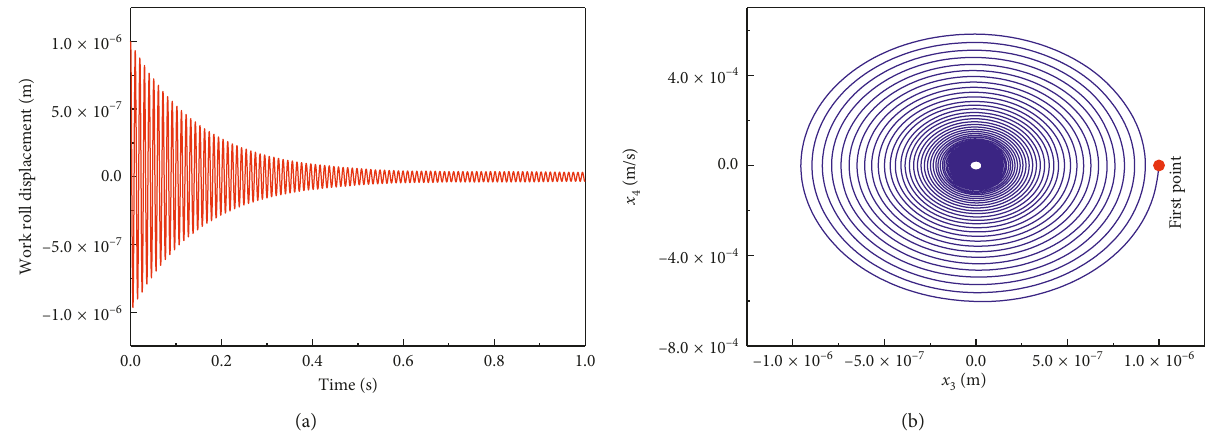
Figure 7: Dynamic response of the work roll displacement and the phase diagram under μ ∗ � 0 . 0300: (a) time history of work roll displacement; (b) phase